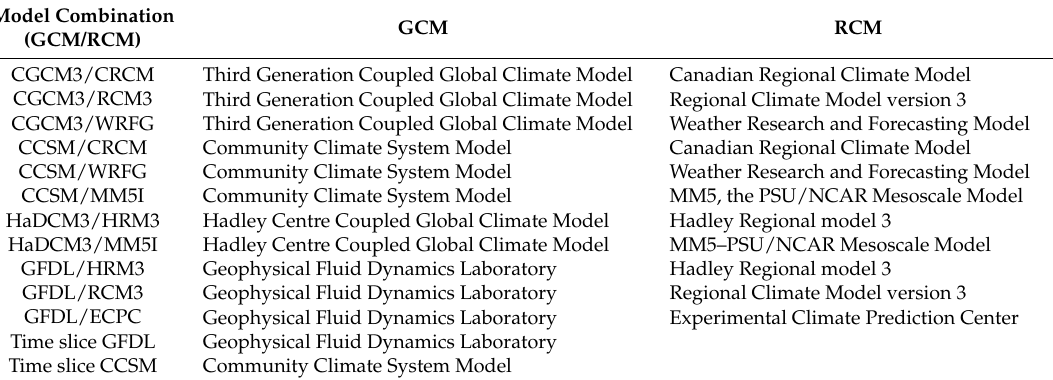
Table 1. Combination of global climate models (GCMs) and regional climate models (RCMs) in the NARCCAP climate models adopted for this